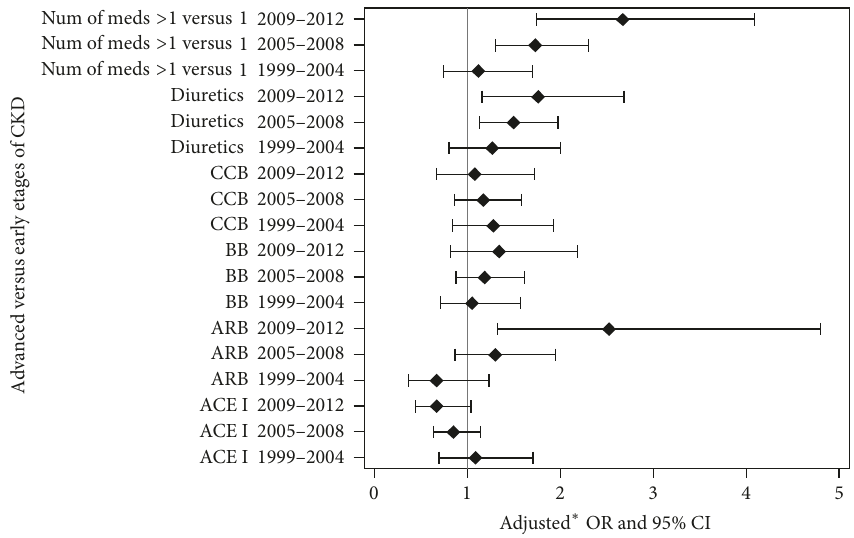
Figure 2: Forest-plots of adjusted ∗ odds ratios (95% CI) for advanced (3, 4, and 5) versus early (1 and 2) stages of CKD by use of five classes of medication. Note . ACEI = Angiotensin Converting Enzyme Inhibitors; ARB = Angiotensin Receptor Blockers; BB = 𝛽 -blockers; CCB = Calcium Channel Blockers; DIU =